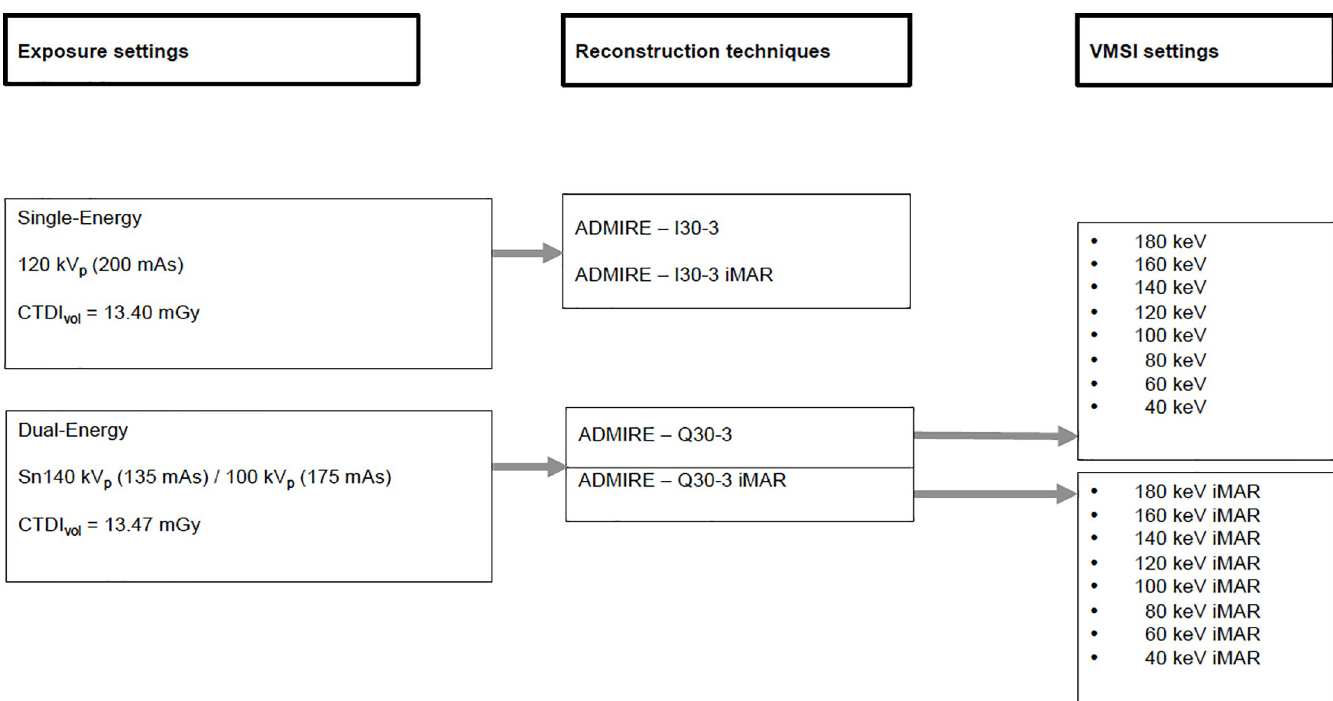
Fig 1. CT acquisition parameters and reconstruction